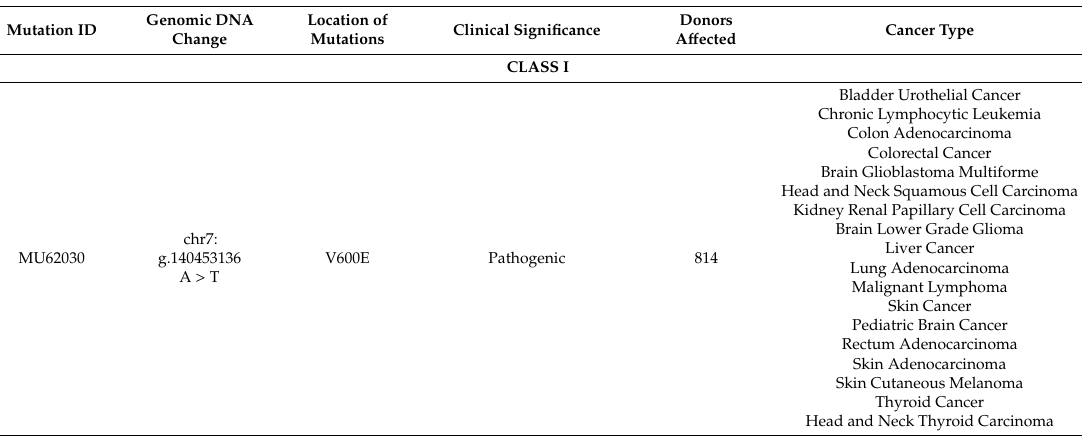
Table 2. Three classes of BRAF mutations identified by the International Cancer Genome Consortium (ICGC) and their clinical significance in di ff erent types of